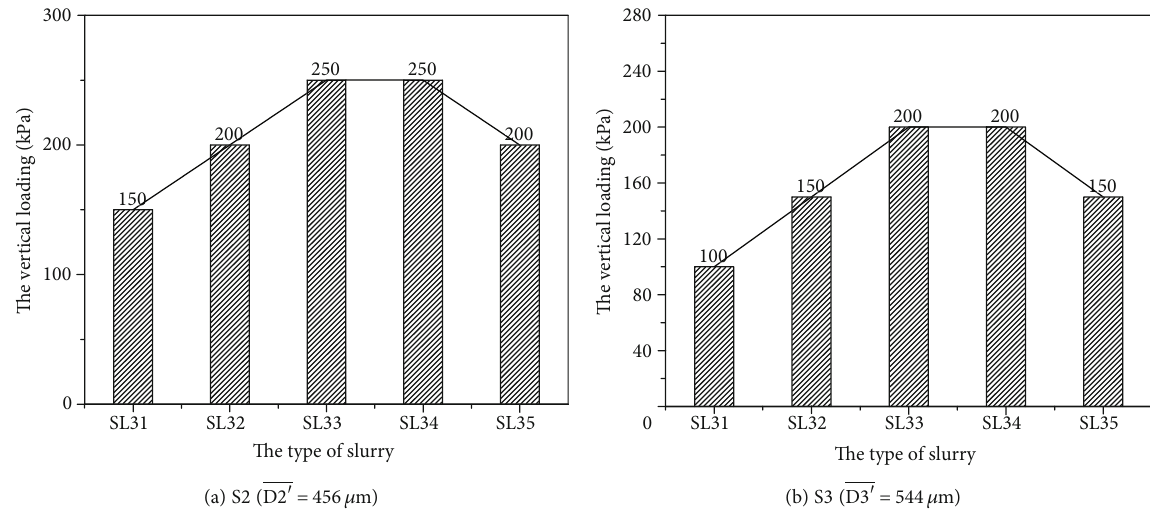
Figure 4: Distribution of the maximum vertical pressure during mud fi lm formation.